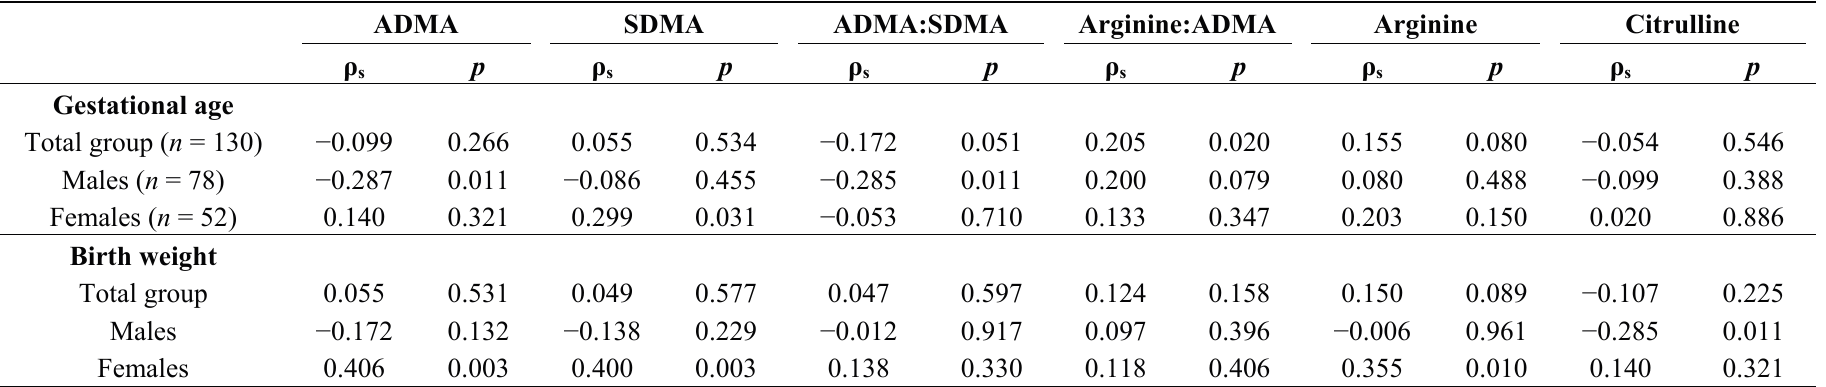
Table 3. Spearman’s Rank Order Correlation between gestational age and birth weight and dimethylarginine, arginine, citrulline levels and ratios in very low birth weight infants.